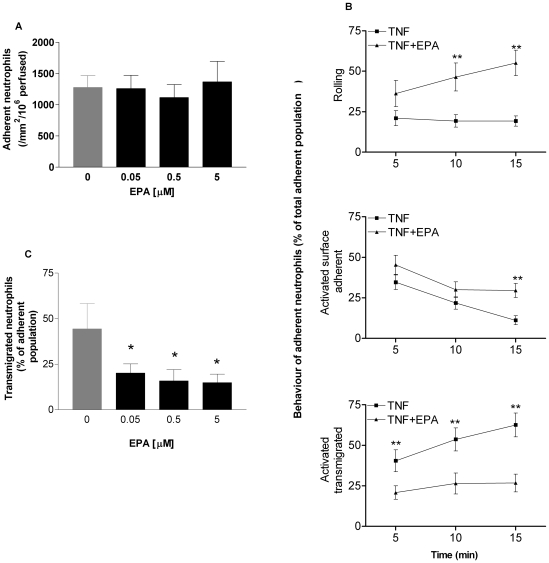
The effects of EPA supplementation on the adhesive behaviour of neutrophils.(A) EPA supplementation did not affect the number of neutrophils initially adhering to endothelial cells from flow. (B) However, the time course of neutrophil behaviour on TNF-stimulated endothelial cells showed that EPA supplementation drastically altered neutrophil behaviour. Thus, the number of activated and surface adherent neutrophils decreased with time in the presence or absence of EPA. However, on endothelium that had not been supplemented with EPA, this was because neutrophils transmigrated across the monolayer, whereas on EPA-supplemented endothelium this was because activated cells reverted back to a rolling form of adhesion. ANOVA showed that there was a significant effect of treatment (i.e., ±EPA) on the percentage of cells that were rolling, surface adherent, or transmigrated (p<0.01). In addition, there was a significant effect of time on each form of behaviour for the EPA-treated cells (p<0.05−0.01). Bonferroni tests showed significant differences at specific time points as marked; **p<0.01. (C) Inhibition of neutrophil transmigration was evident at levels of EPA supplementation as low as 50 nM. Data are mean±SEM of five experiments. ANOVA showed significant effects of treatment (p<0.05); *p<0.05 compared to untreated control by Dunnett's test. Error bars indicate SEM.